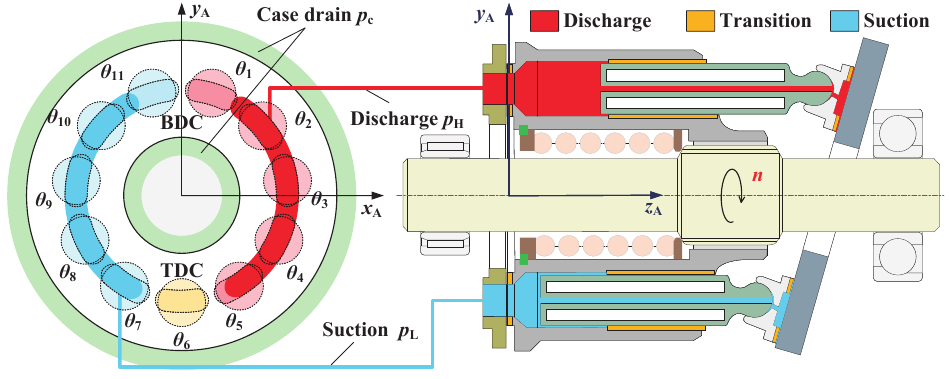
Figure 8. Pressure boundary of the oil